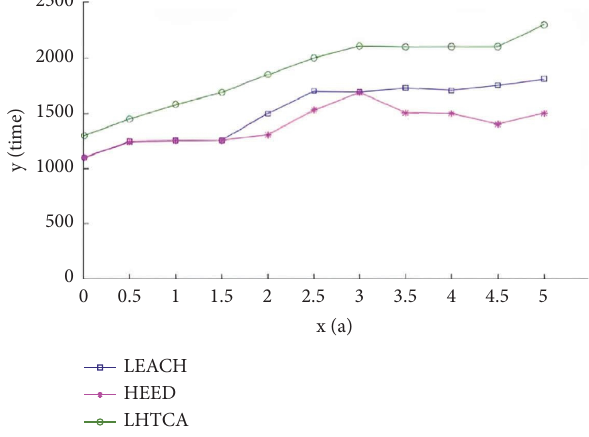
Figure 8: Life cycle comparison